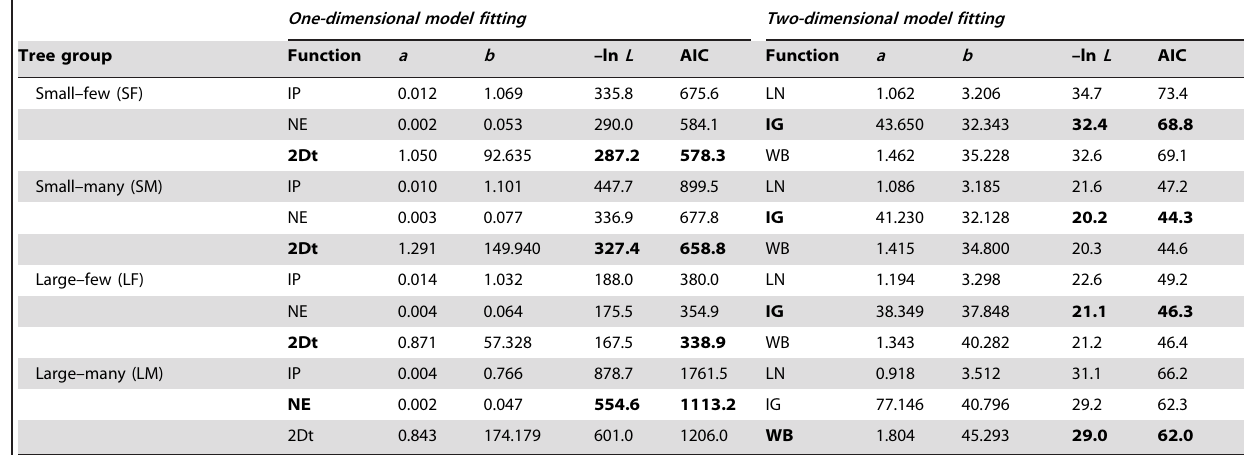
Table 4. Estimated parameters and fit statistics of empirical dispersal models for 25 mahogany ( Swietenia macrophylla ) trees at the Marajoara forest, Para´,